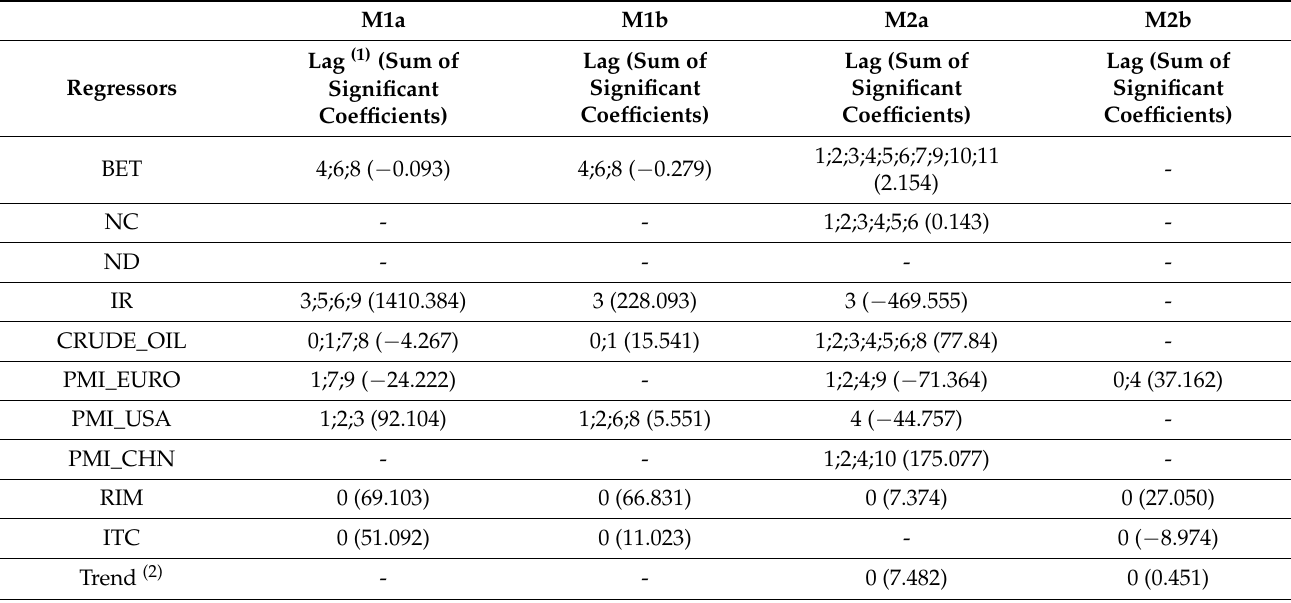
Table 7. Significant coefficients for particular lags in the ARDL